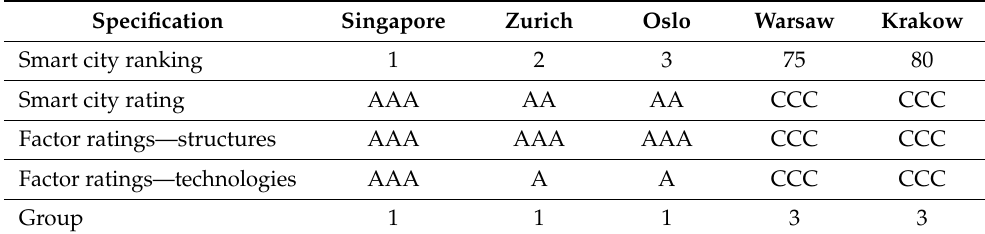
Table 1. A cumulative list of smart city scoring on the basis of the IMD-SUTD Smart City Index (SCI)—an overview